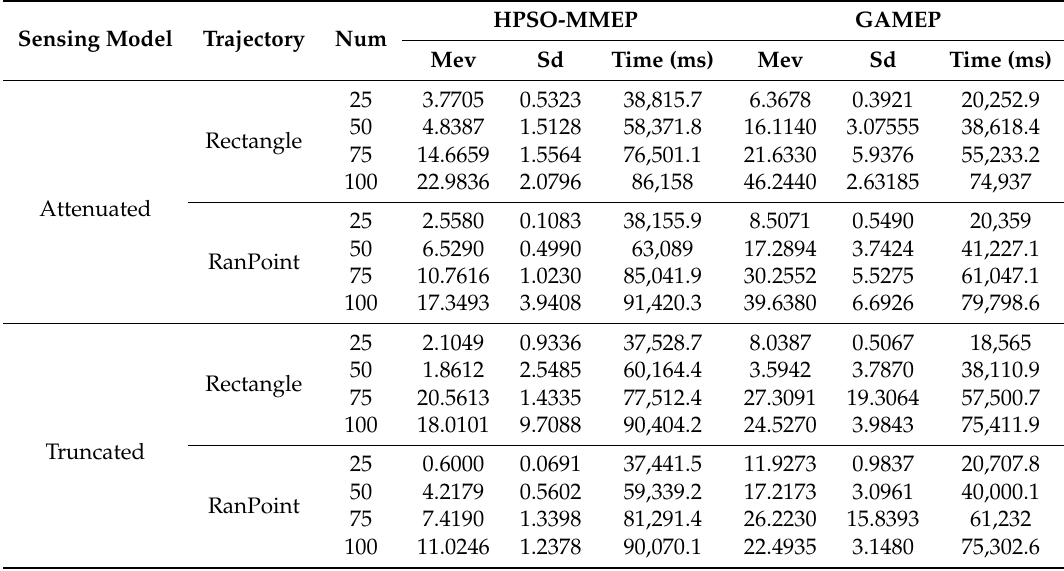
Table 7. Computation results of HPSO-MMEP in comparison with GAMEP in Gauss distribution of sensors (Mev: minimal exposure value, Sd: standard